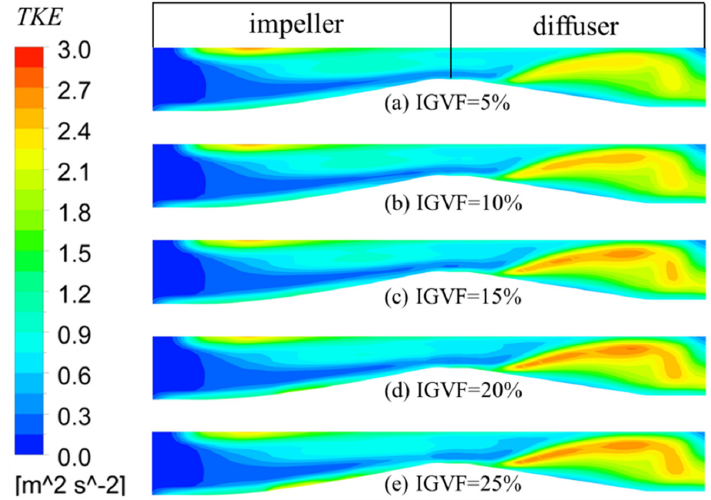
Figure 11. Distribution of turbulence kinetic energy in the impeller and diffuser under different IGVFs.